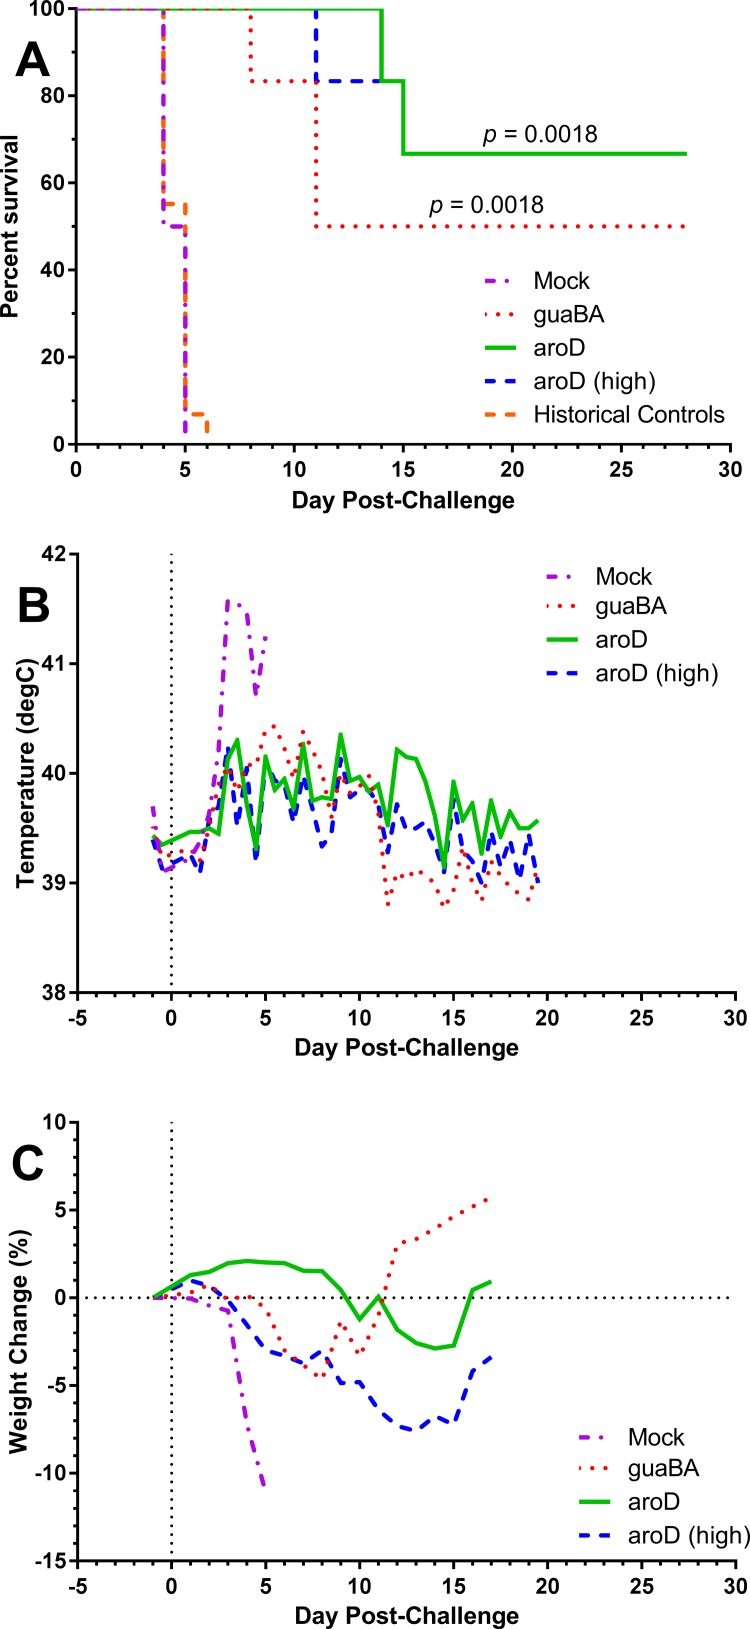
Prime-boost vaccination improves survival at higher SCHU S4 challenge doses.Rabbits were vaccinated by APAB with S4ΔaroD or S4ΔguaBA prior to aerosol challenge with SCHU S4. Graphs show survival among rabbits vaccinated with S4ΔaroD and S4ΔguaBA and challenged with 1,475 cfu (solid and dotted lines, respectively) as well as S4ΔaroD vaccinated rabbits challenged with 6,316 cfu (designated aroD (high), dashed line). Survival was tracked for 28 days post-challenge; body temperature and weight were tracked until day 18–21, when rabbits had returned to baseline values. Mock-vaccinated rabbits are also shown. Graphs show A) survival post-challenge. By Kaplan-Meier analysis, survival in all three vaccine groups was significantly different from mock vaccinated controls. S4ΔguaBA: 50% survival, p = 0.0018; S4ΔaroD: 66% survival, p = 0.0018; S4ΔaroD(high challenge dose): 66% survival, p = 0.0018. Historical naïve or mock-vaccinated controls given equivalent challenge doses are also shown (n = 29). B) average body temperature by group post-challenge, and C) average weight loss by group post-challenge.